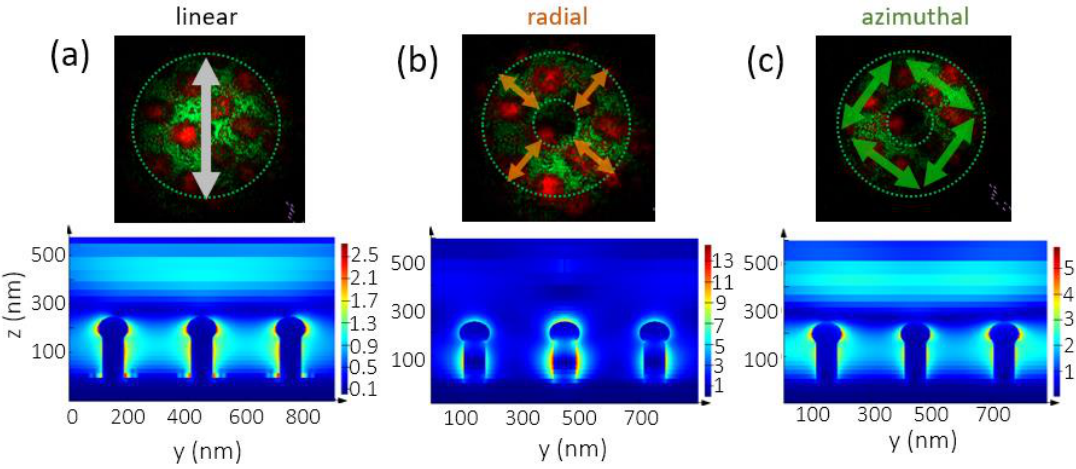
Figure 6. Numerical simulation of the electric field distribution for laser radiation with λ = 600 nm for the different polarizations: linear ( a ), radial ( b ) and azimuthal ( c ). Color scale in |E|/|E 0 |.